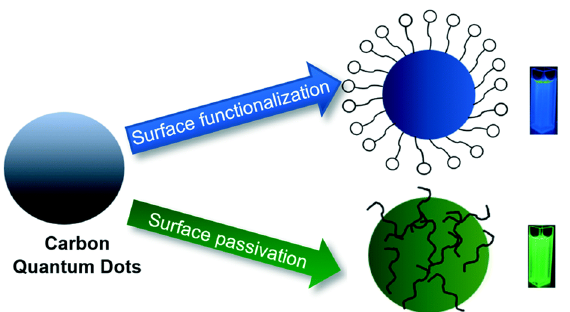
Figure 4. Surface passivation and functionalization of CDs—Reproduced with permission from [29] published by The Royal Society of Chemistry, 2019.